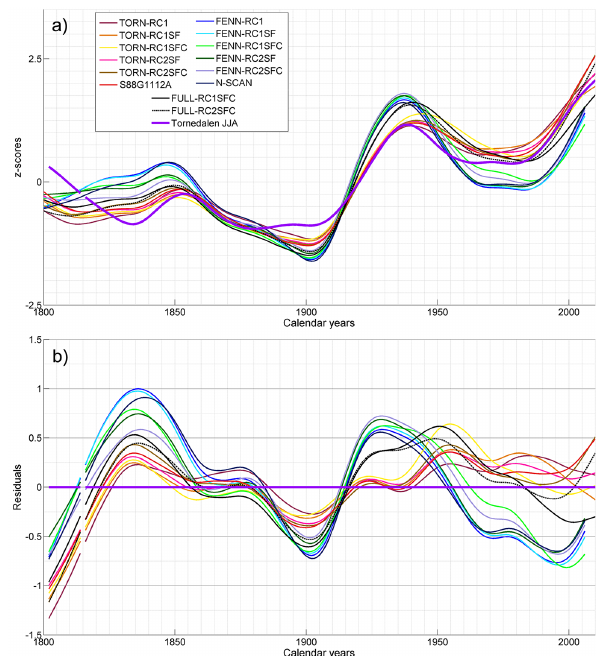
Figure 6. TORN, FENN and FULL chronologies with Tornedalen JJA temperatures (a) and residuals of the chronologies from Tornedalen JJA temperatures (b) . Variance and mean adjusted to AD 1802–2006 using 15yr smoothed data. All the data smoothed with 50yr splines. S88G1112A (Melvin et al., 2013) and N-SCAN (Esper et al., 2012) are original chronologies for the TORN and FENN data sets,